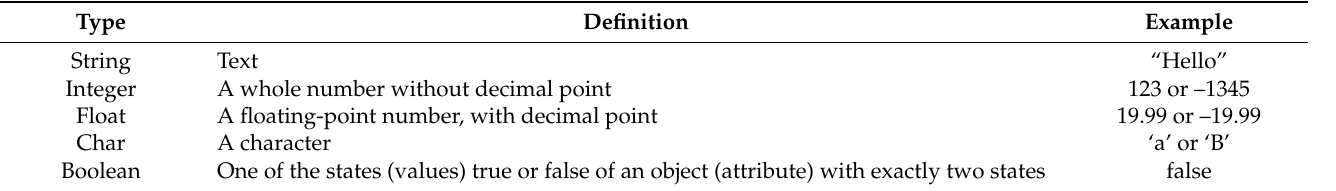
Table 2. Computational object value types: definitions and